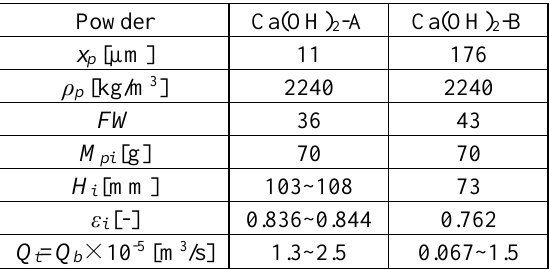
Table 1. Particle properties and experimental